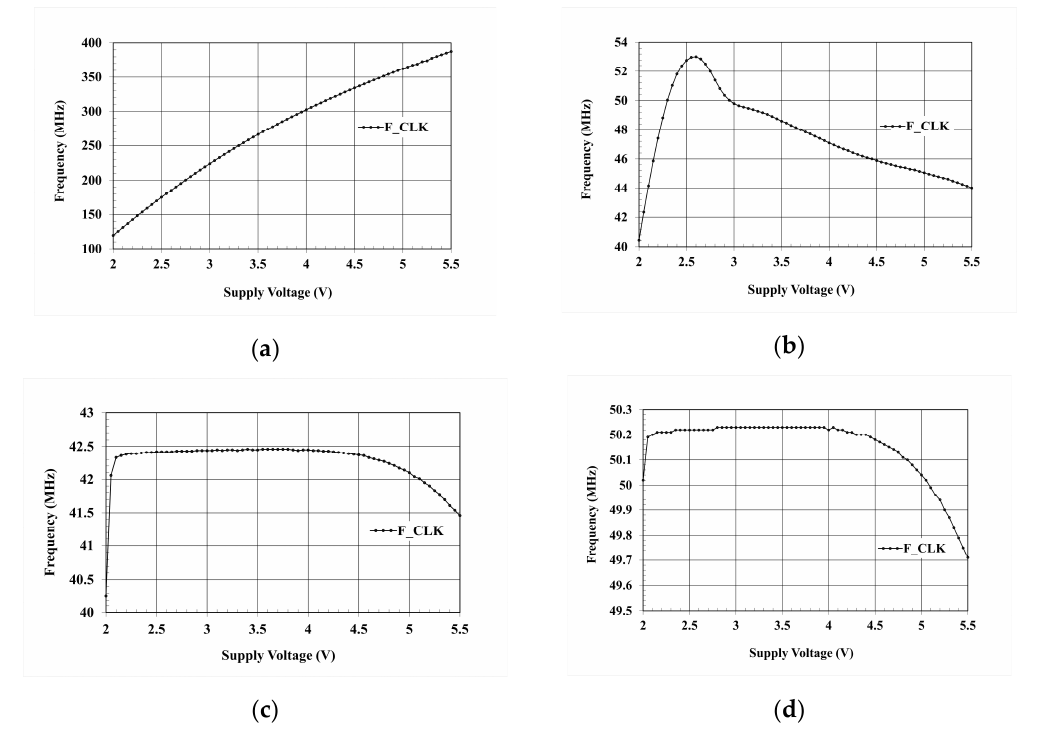
Figure 6. Frequency dependency given by supply voltage for the ring oscillator. ( a ) Basic implemen- tation; ( b ) Current−starved added; ( c ) Internal supply voltage and current−starved connected; ( d ) Proposed design with cascaded current−starved.